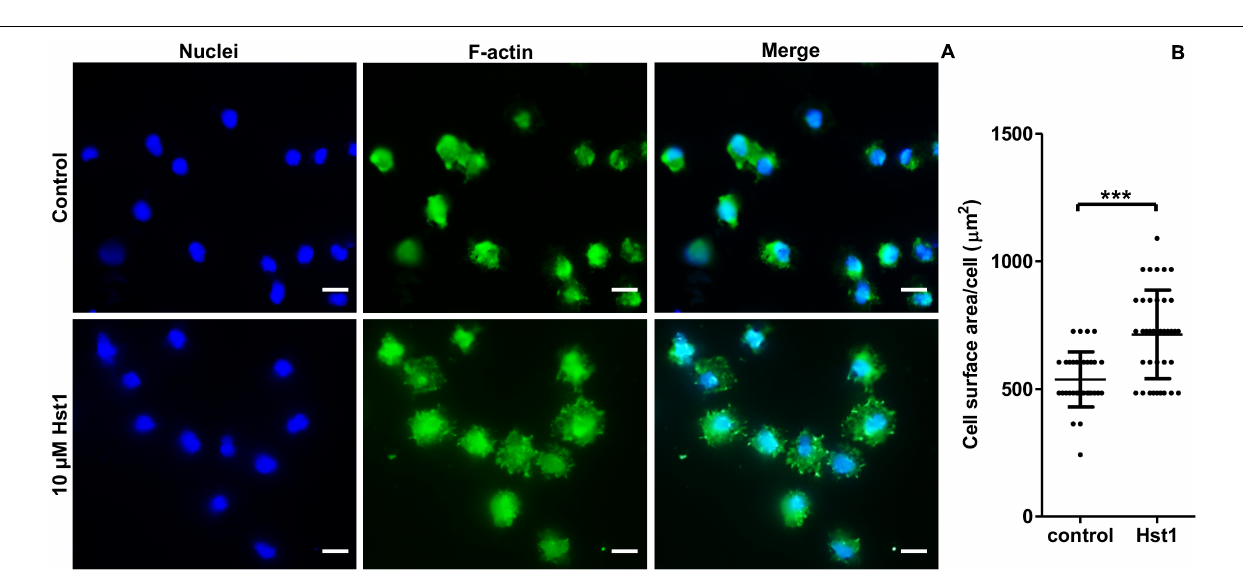
Frontiers in Bioengineering and Biotechnology |